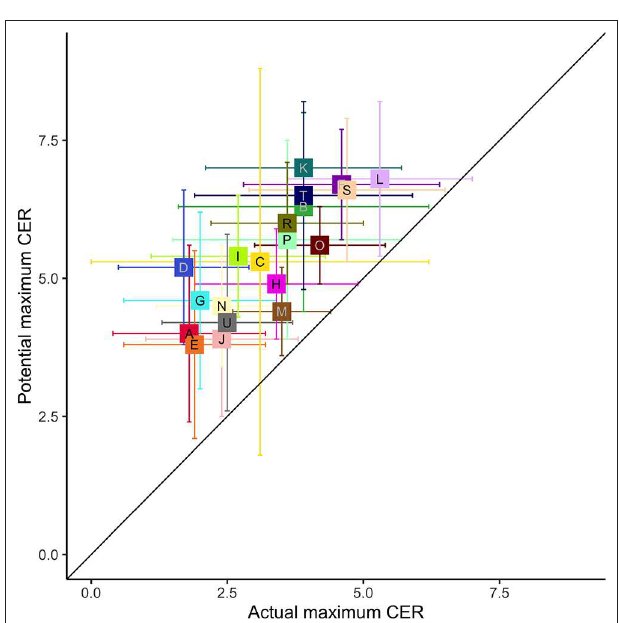
FIGURE 8 | The actual maximum CER for 2008–2018 and the maximum predicted value (rainfed or irrigated). Values are mean and standard deviation for each LRR, following the colors and letter code given in Figure 1 and Table 1 .